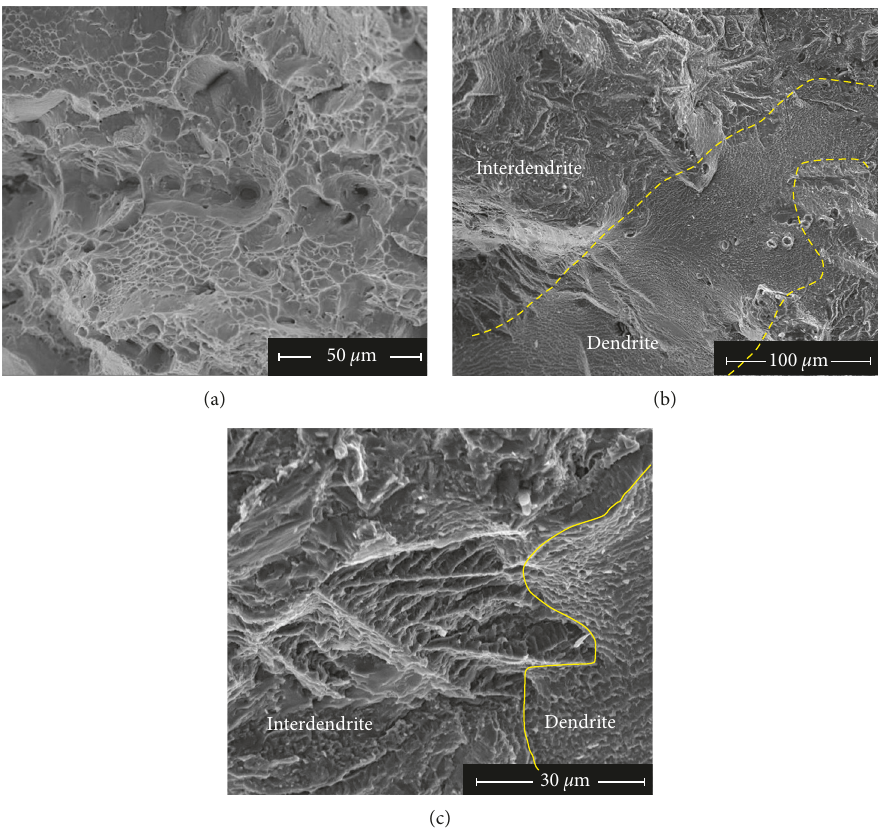
Figure 4: Fracture surfaces of (a) wrought and (b) cast alloys, and (c) magnified view of the border region between the dendritic and interdendritic regions of the cast alloy after the tensile test at room temperature.